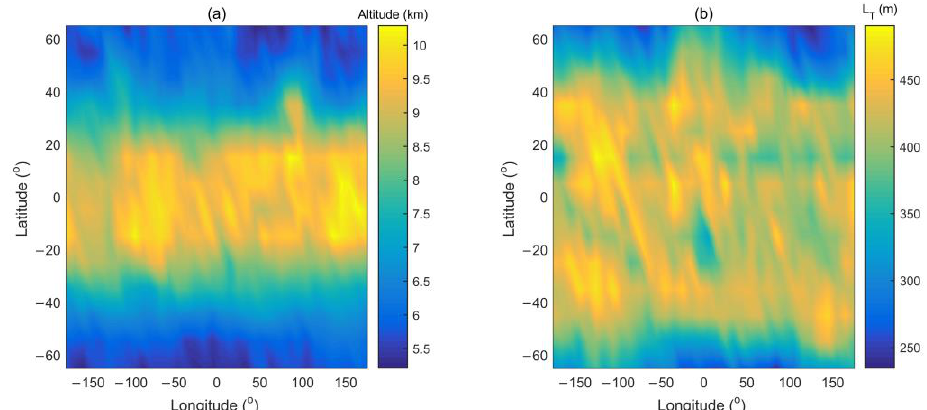
Figure 2. Altitude ( a ) and L T ( b ) of the strongest mixed layer of the troposphere (SMLT) spatial distribution in Spring 2007.